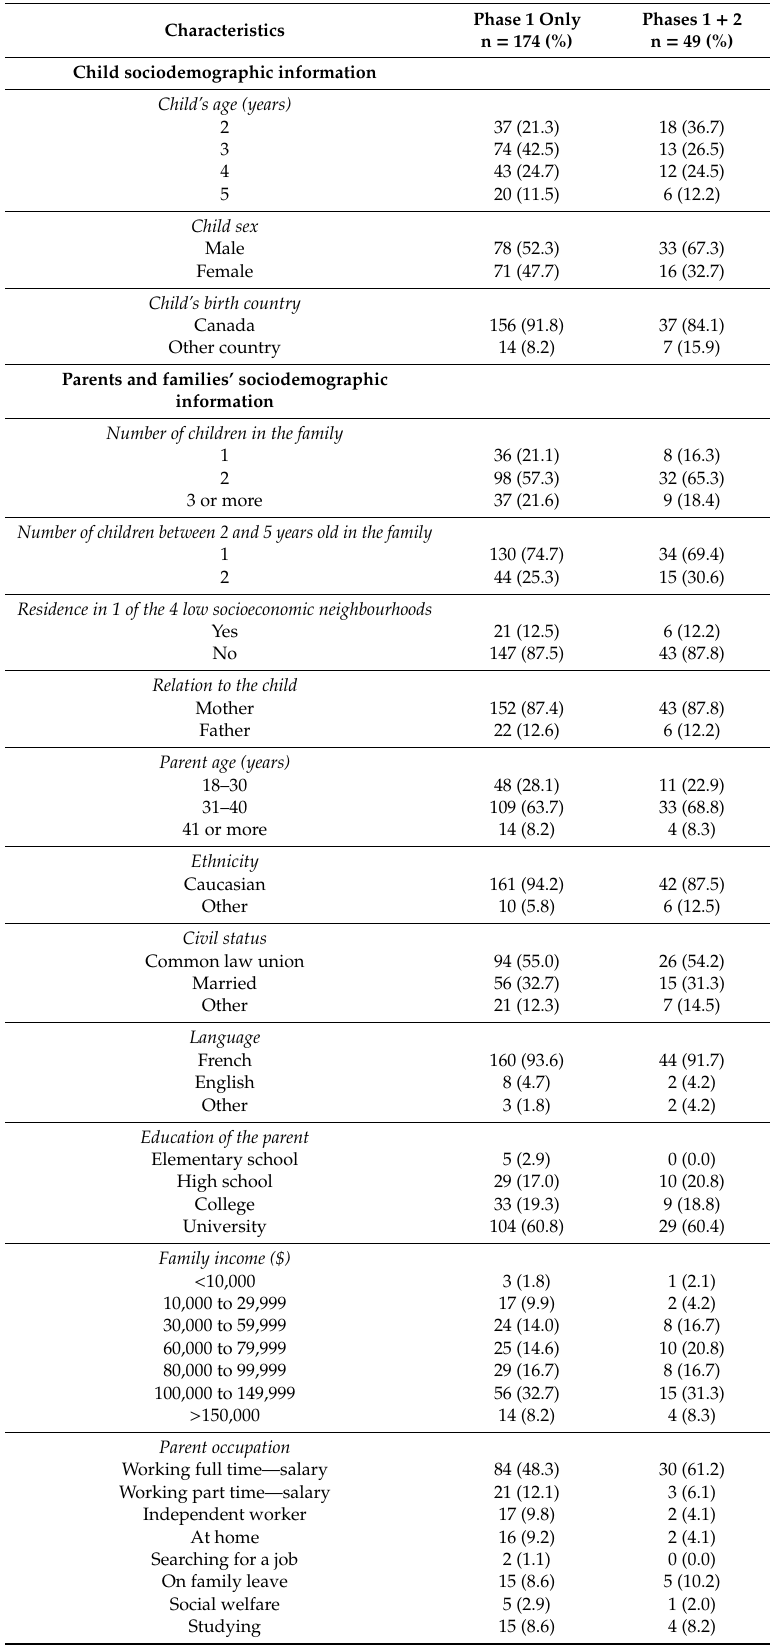
Table 1. Parent and child sociodemographic